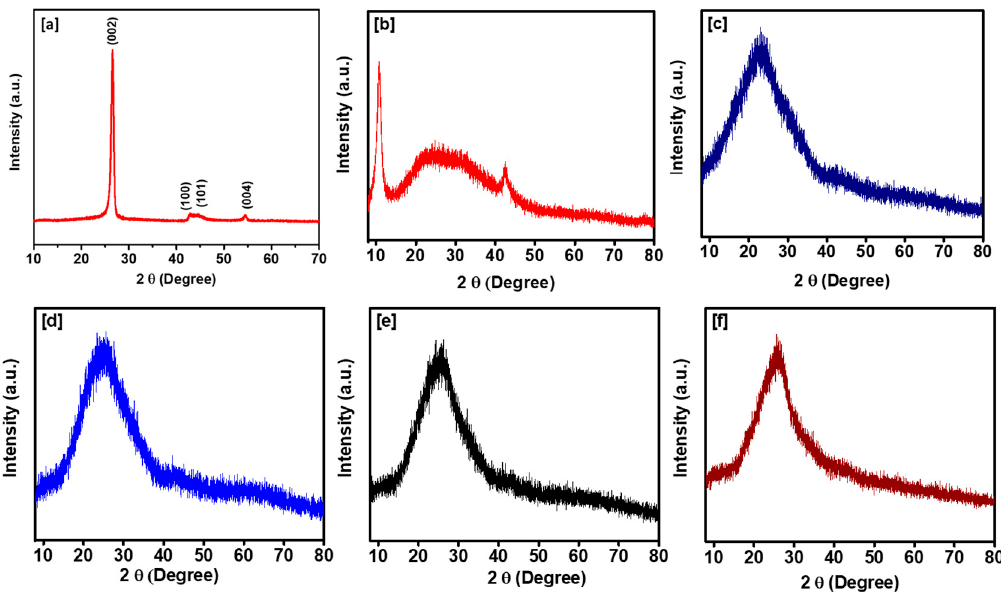
Figure 3. XRD patterns of ( a ) MWCNTs; ( b ) GONRs; ( c ) polypyrrole; ( d ) 0.5 PPyGONR; ( e ) 1.5 PPyGONR; and ( f ) 3 PPyGONR.